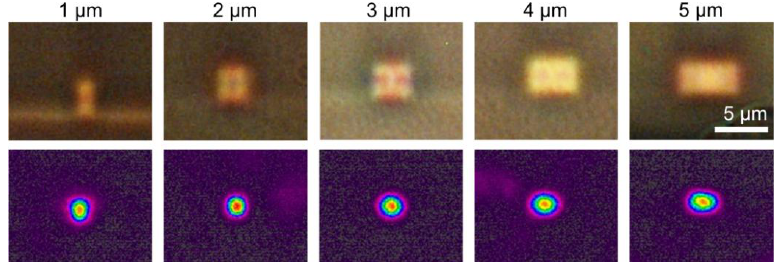
Figure 6. Cross-sectional microscope images of 3 µm thick imprinted waveguides having different target widths (as mentioned in the column header) and corresponding mode field profiles imaged at the waveguide end-face (λ = 850